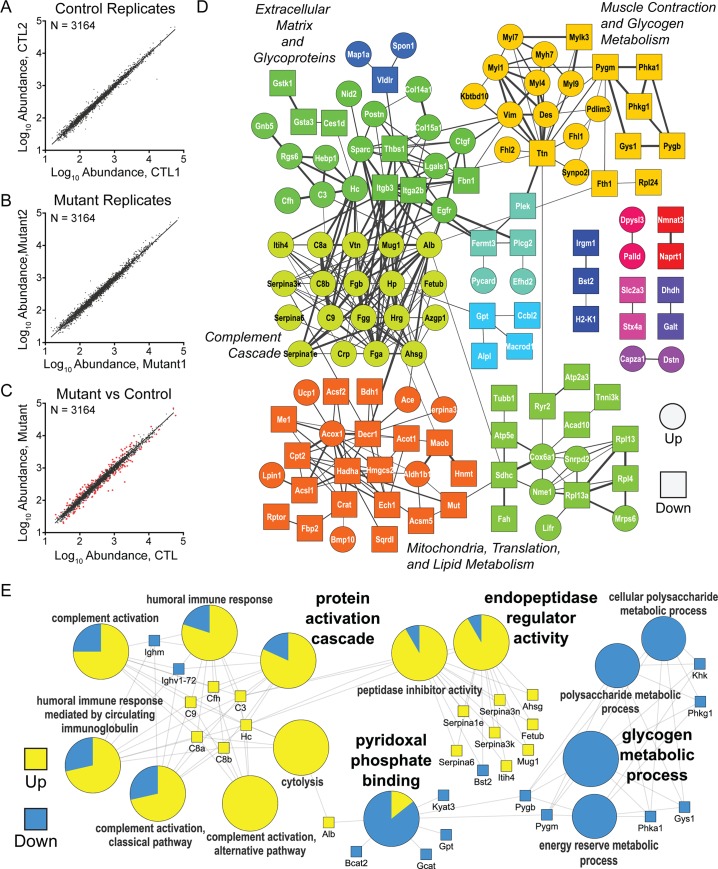
Proteomic analysis of DCM mouse hearts reveals activation of complement cascades and decreased protein abundance involved in glycogen metabolic processes.(A-B) Comparison of normalized protein abundances (black dots, n = 3164) quantified by TMT-based proteomics between biological replicates of (A) Nkx2.5Cre (Control, CTL) and (B) Tbx20flox/+; Casz1flox/+; Nkx2.5Cre (Mutant) mouse hearts. (C) Comparison of average normalized TMT protein abundances between Mutant and CTL mouse hearts (n = 2). Proteins classified as differentially abundant in the Mutant (TMT abundance ratios ≥ ±1/3-fold in both replicates) are indicated (red dots, n = 175). (D) Functional interaction network of differentially abundant proteins constructed using STRING interaction database. Proteins with up- and down-regulated abundances are represented by circle and square nodes, respectively, and labeled with primary gene symbols. Proteins that did not have connectivity to at least one other protein were excluded. Nodes are color-coded by cluster connectivity, which was assigned by the ReactomeF1 plug-in (see Methods). (See S7 Fig) Network edges reflect known STRING database relationships (confidence score >0.4). Edge thickness correlates with STRING confidence score (0.4–1). (E) Gene ontology (GO)-based network of selected over-represented Biological Processes represented by the differentially abundant proteins. Over-represented GO terms (p-value <0.05) are colored according to the proportion of the total differentially abundant proteins annotated to that term that were up- (yellow) or down- (blue) regulated. Protein to GO term assignments are indicated by network edges connecting the respective gene symbols (squares) with their assigned GO term.